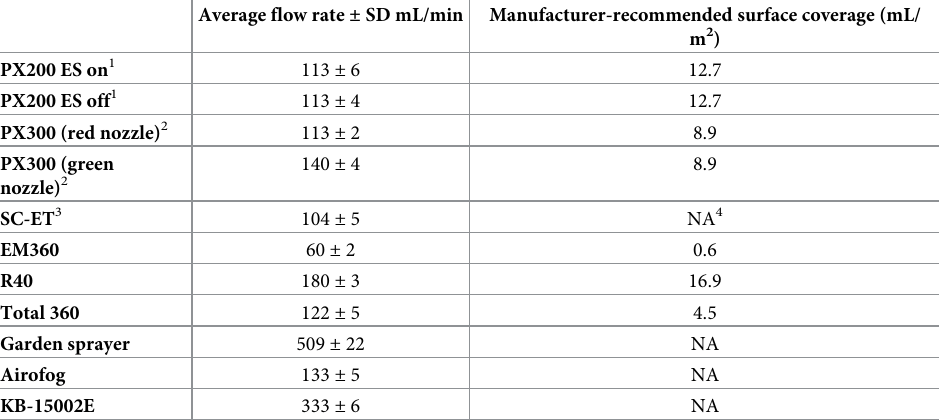
Table 2. Summary of device flow rates and recommended surface